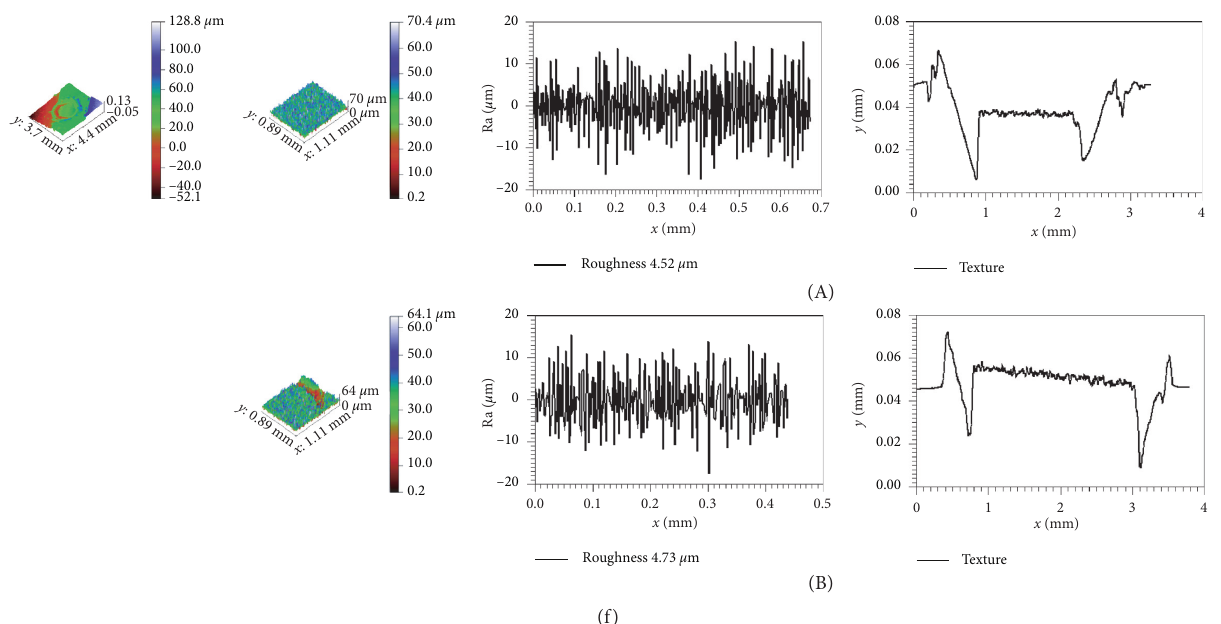
Figure 17: 3D profilometer image, roughness profile, and texture analysis of the wear scar ((A) 50N load and (B) 300N load). (a) Base composition. (b) Composition 1. (c) Composition 2. (d) Composition 3. (e) Composition 4. (f) Composition